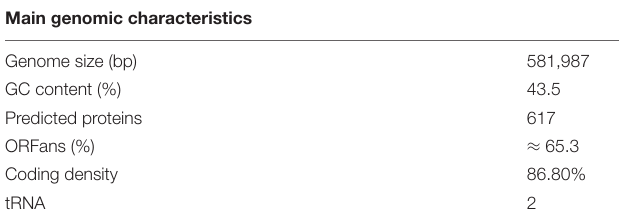
TABLE 1 | Genomic characteristics of